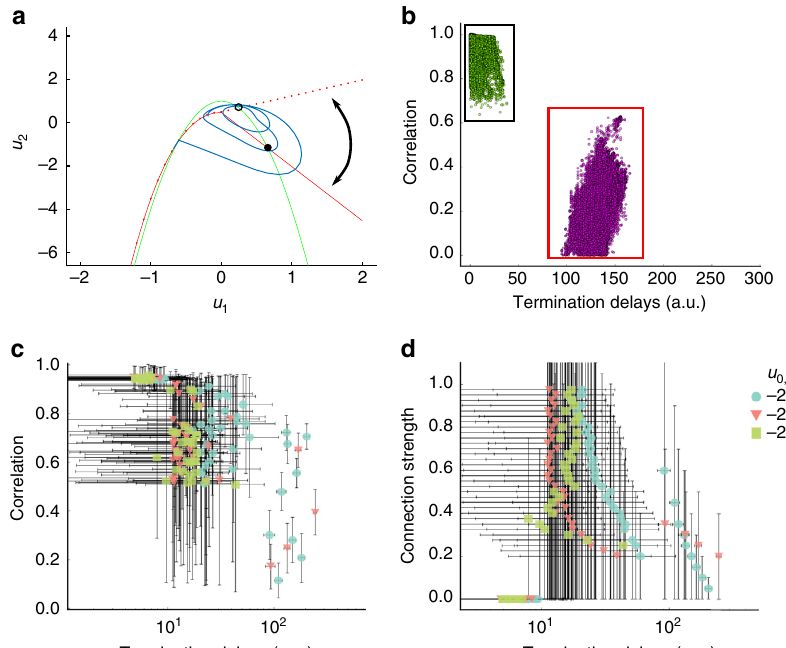
Fig. 6 Synchronized seizure termination results from the fast propagation of ictal SWDs. a Phase space for the fast population ( u 1 and u 2 ) of the Epileptor fi eld model at seizure offset. The slope of the straight part of the red nullcline changes when a SWD occurs, transforming the stable fi xed point (black dot) into an unstable fi xed point (black circle) and allowing for fast oscillations to emerge (blue trajectory) and cross the separatrix via a homoclinic bifurcation. The homoclinic bifurcation results in the termination of the seizure. The curved arrow represents the change in the nullcline before and after a SWD. b Pairwise correlations between different sites in the neural fi eld model as a function of seizure termination delays. Same seizure simulation as in Fig. 2, except that noise was added (see Methods). Black (red) rectangle: pairwise correlation for spatial locations in the same (different) Epileptor fi eld model. Lower correlation values are obtained when the pairwise sites are in different fi elds (red rectangle). Green and violet dots indicate different clusters obtained via automated clustering (Methods) of the termination delays. c Mean pairwise correlation between different sites in the Epileptor fi eld model as a function of termination delays for different values of the excitability ( u 0,2 ) of the second fi eld and of the heterogeneous coupling strength ( γ het,2 ). Each point corresponds to the mean for each one of the clusters obtained as in b . Each color/symbol indicates a different excitability value. The vertical and horizontal bars indicate the standard deviations in the corresponding coordinates. Note the log scale in the x -axis. d Same conventions as in c , except by showing instead mean pairwise connection